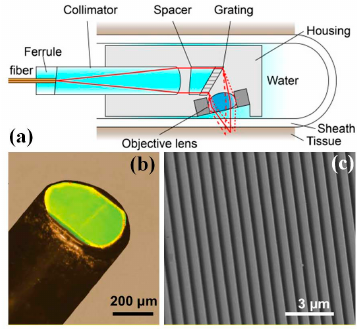
Figure 15. Miniaturized grating based spectrally encoded confocal microscope (SECM): ( a ) Schematic drawing of SECM endomicroscope optics and system; ( b ) photograph of the tip of the grating; and ( c ) SEM imaging of the tip of the grating (R eproduced with permission from OSA [95]).